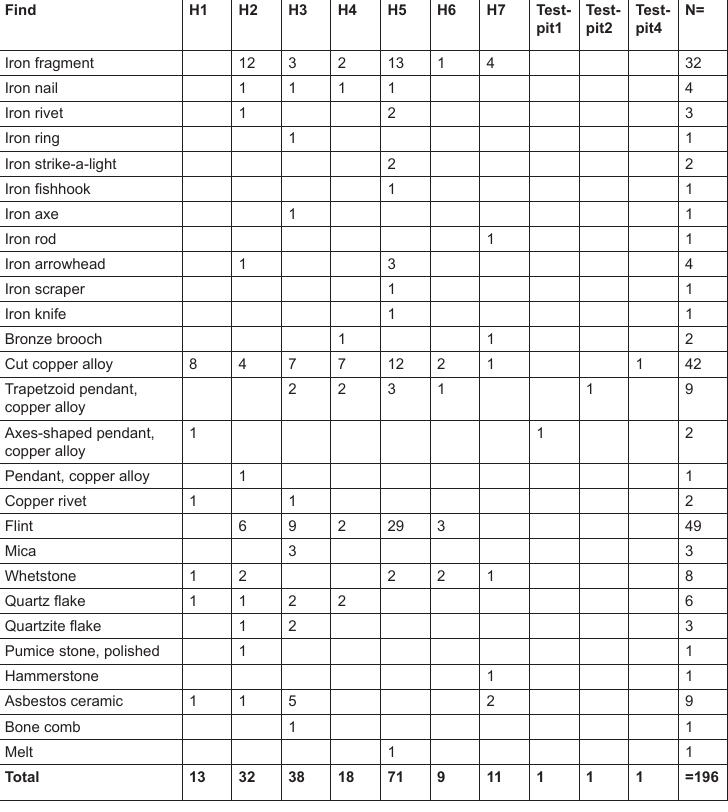
Table 1. The artefacts from Brodtkorbneset.